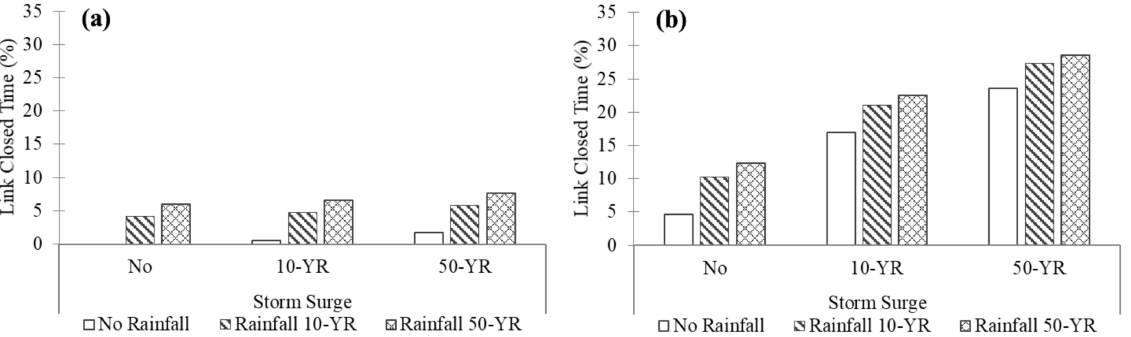
Figure 16. Total links closed time ( TLCT ) for all road links in the study domain under the analyzed storm scenarios: ( a ) 2020 conditions and ( b ) 2070 conditions with high SLR and RCP8.5 climate change